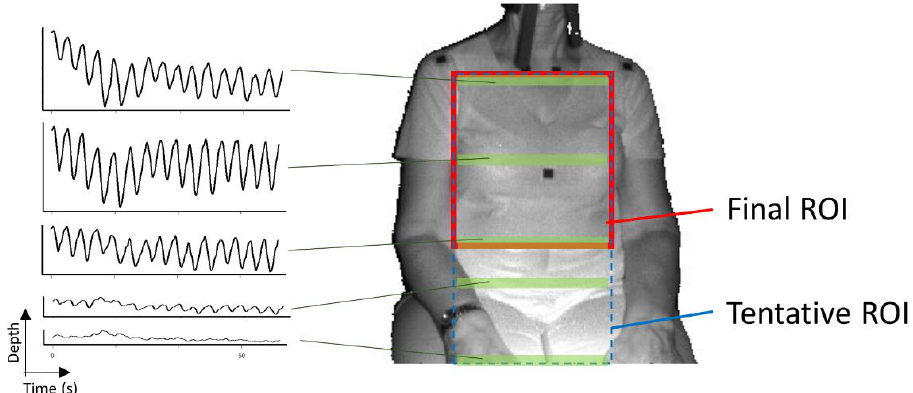
Figure 5. Final ROI, tentative ROI, and some of the depth waveforms.